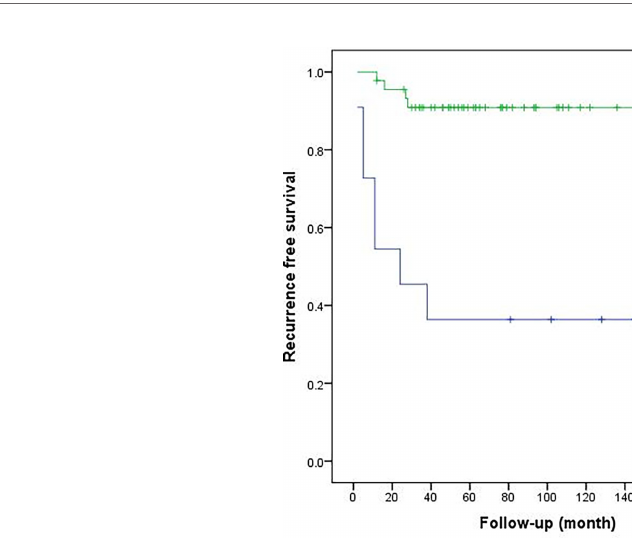
FIGURE 3 | Comparison of recurrence-free survival between inadequate and adequate surgical margins (P <